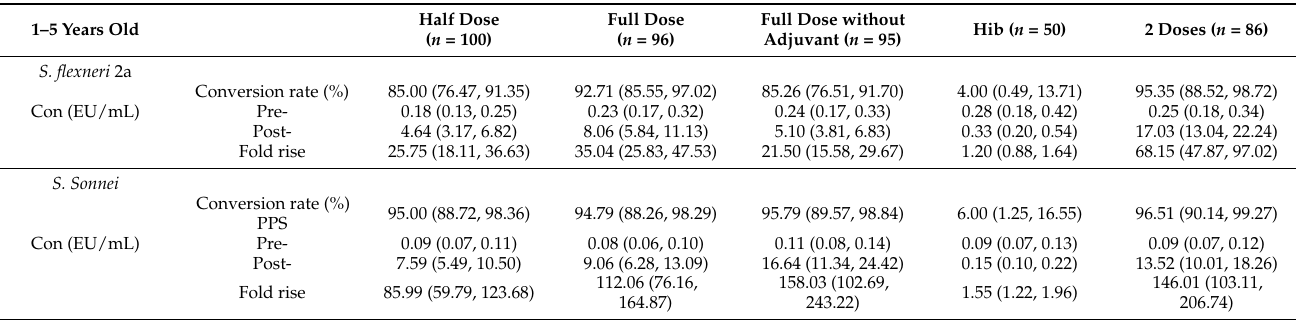
Table 4. Immunological response for children aged 1–5 years old with different vaccines and